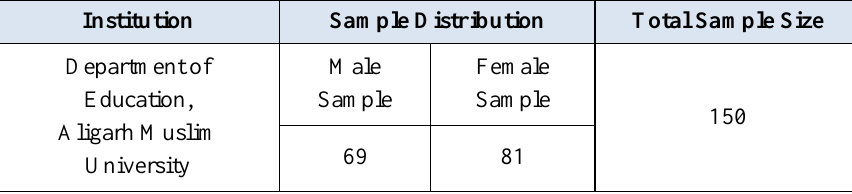
Table 1. Sample of the